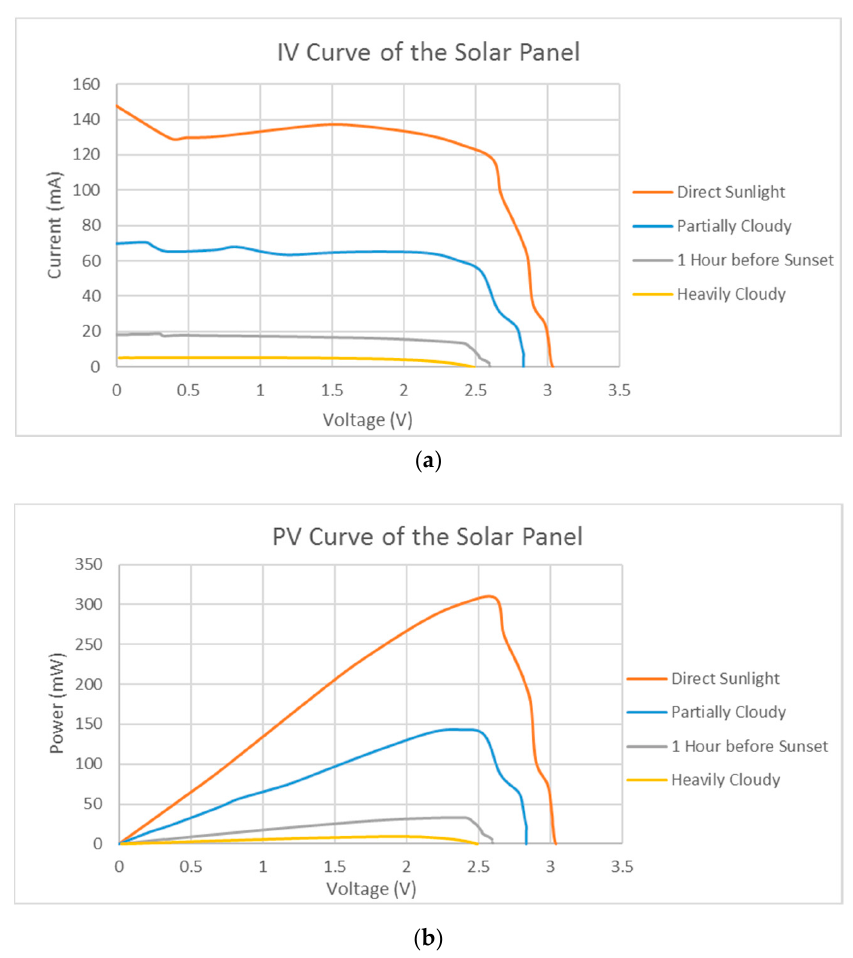
Figure 3. ( a ) Current–voltage (IV) curve of the solar panel; ( b ) power–voltage (PV) curve of the solar panel.